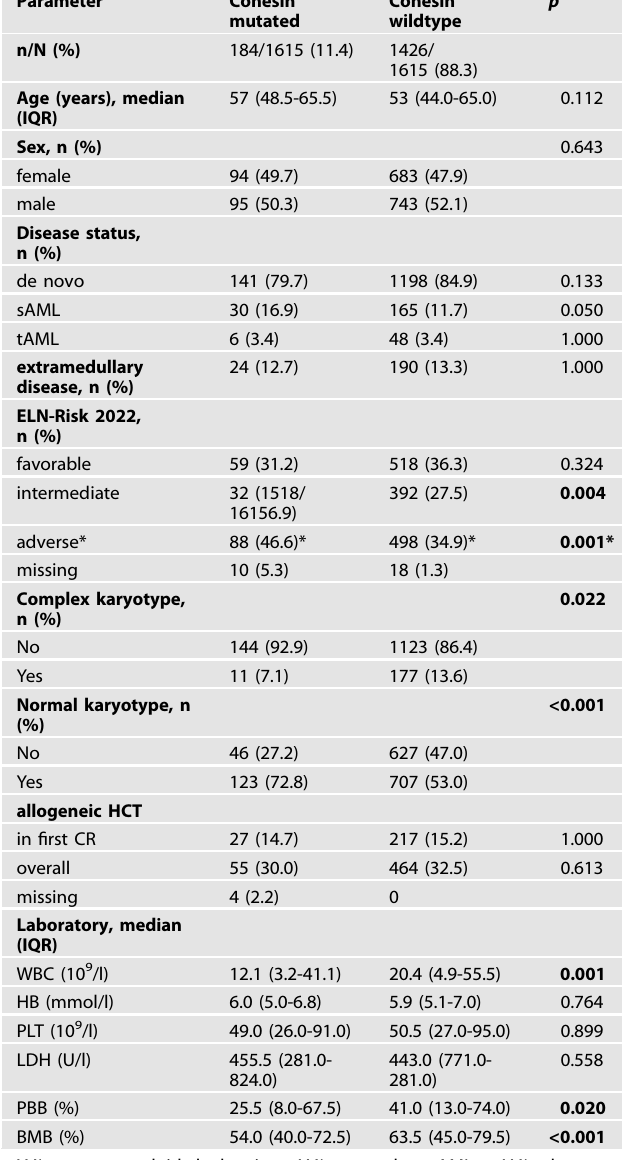
Table 1. Baseline patient characteristics with respect to cohesin mutation